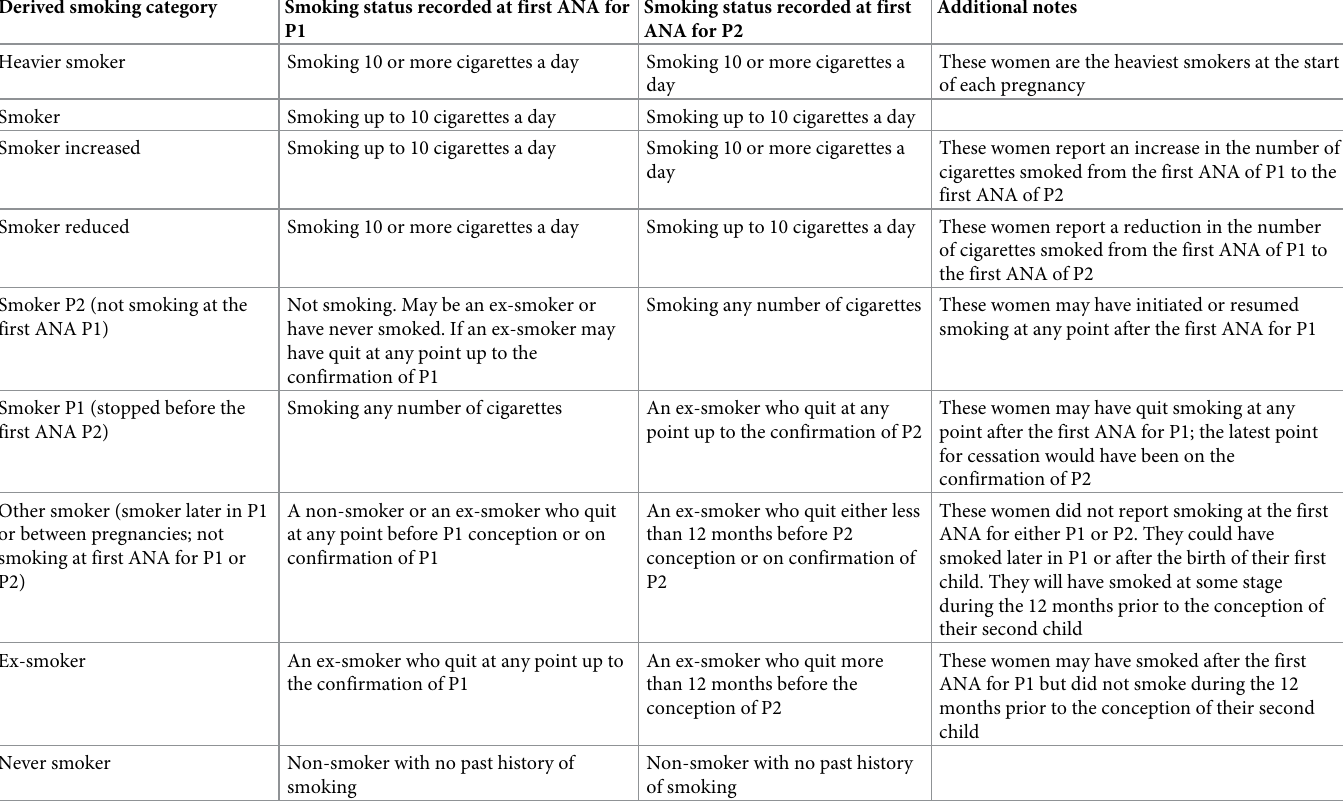
Table 1. Summary of derived smoking categories based on self-reported maternal smoking status recorded at the first antenatal appointment for each pregnancy. Derived smoking